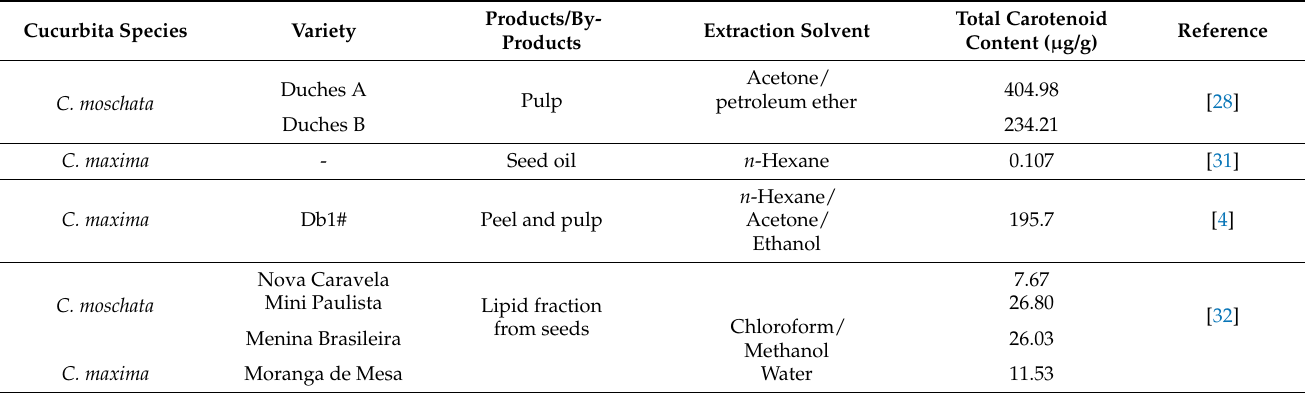
Table 2. Total content of carotenoids in pumpkin products and